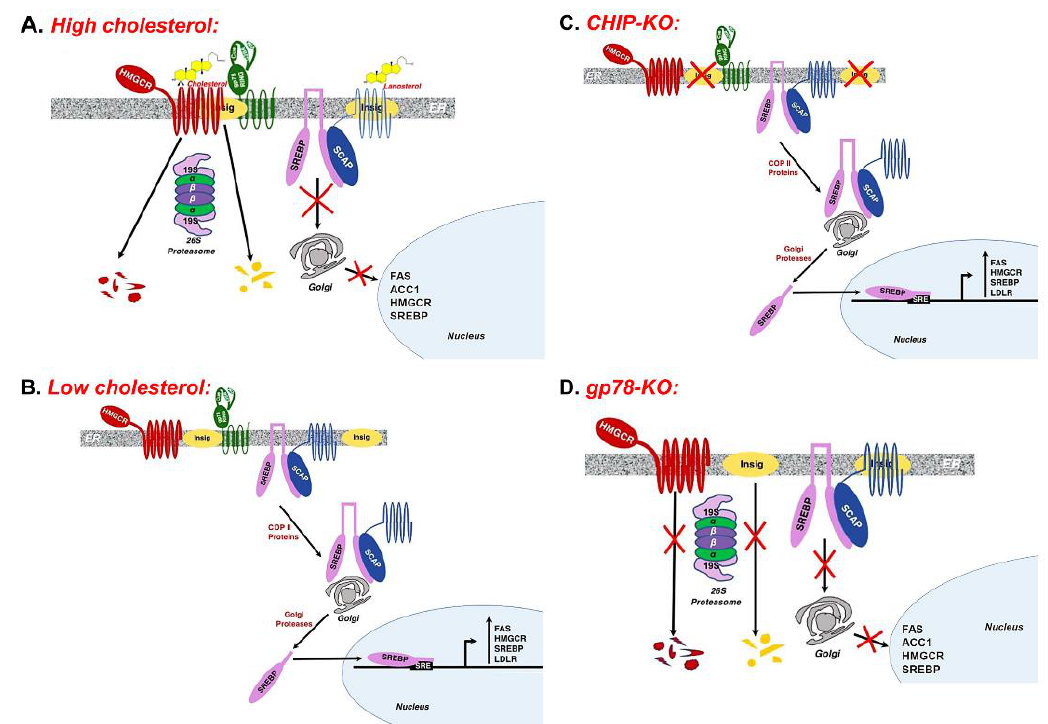
Figure 1. The hepatic INSIG-SCAP-SREBP1 axis and its activation under certain conditions. ( A ) Under high sterol levels, the endoplasmic reticulum (ER)-polytopic HMGCR, the rate-limiting enzyme in sterol synthesis, associates with the ER-integral Insig-gp78 complex, resulting in the gp78-mediated ERAD/UPD of both HMGCR and Insigs. High sterol levels also enhance the association of the SREBP-SCAP-INSIG complex resulting in their ER-retention and preventing the transcriptional activation of lipogenesis and steroidogenesis. ( B ) When sterol levels drop, SREBP-SCAP dissociates from the Insigs are escorted by COPII proteins to the Golgi wherein the precursor SREBPs are N-terminally processed by Golgi proteases into their corresponding transcriptionally active nuclear species. The nuclear SREBP species activates the transcription of various genes including lipogenic (FAS, ACC1), steroidogenic (HMGCR) as well as SREBP genes. ( C ) Upon CHIP-KO, drop of Insig ER-levels possibly due to insulin resistance, release SREBP-SCAP from the ER with their subsequent transport to the Golgi and processing into the transcriptionally active forms, resulting in enhanced hepatic lipogenesis and steroidogenesis. ( D ) Upon gp78-KO, by contrast, HMGCR and Insigs are stabilized in the ER, leading to the retention of the SREBP-SCAP complex within the ER and consequent abortion of the SREBP proteolytic processing into the transcriptionally active nuclear species. Figures were based on literature reports [29,34–46]. HMGCR: HMG CoA Reductase; Insig: Insulin-induced gene; SCAP: